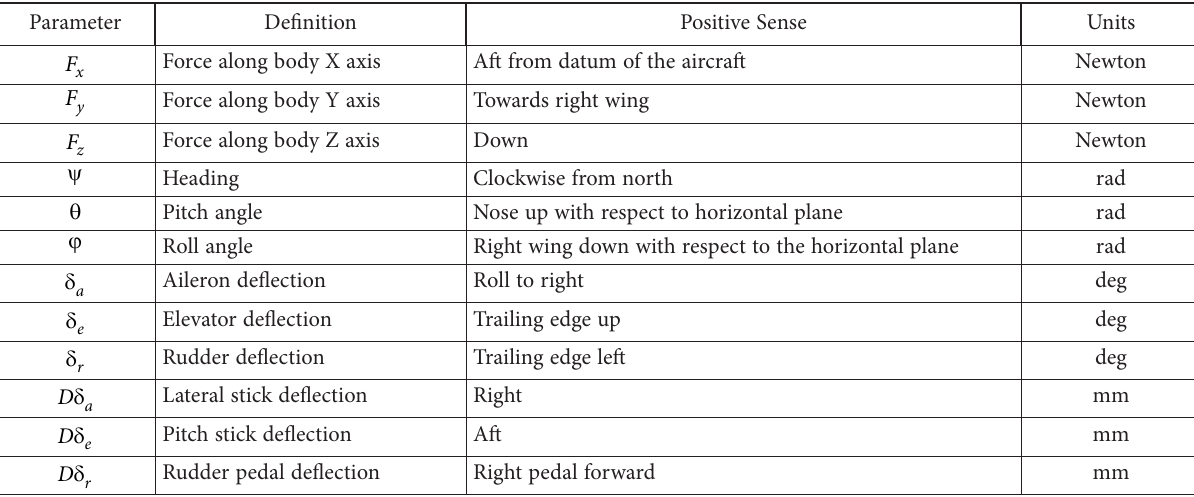
Table 1. Sign Convention for the implementation